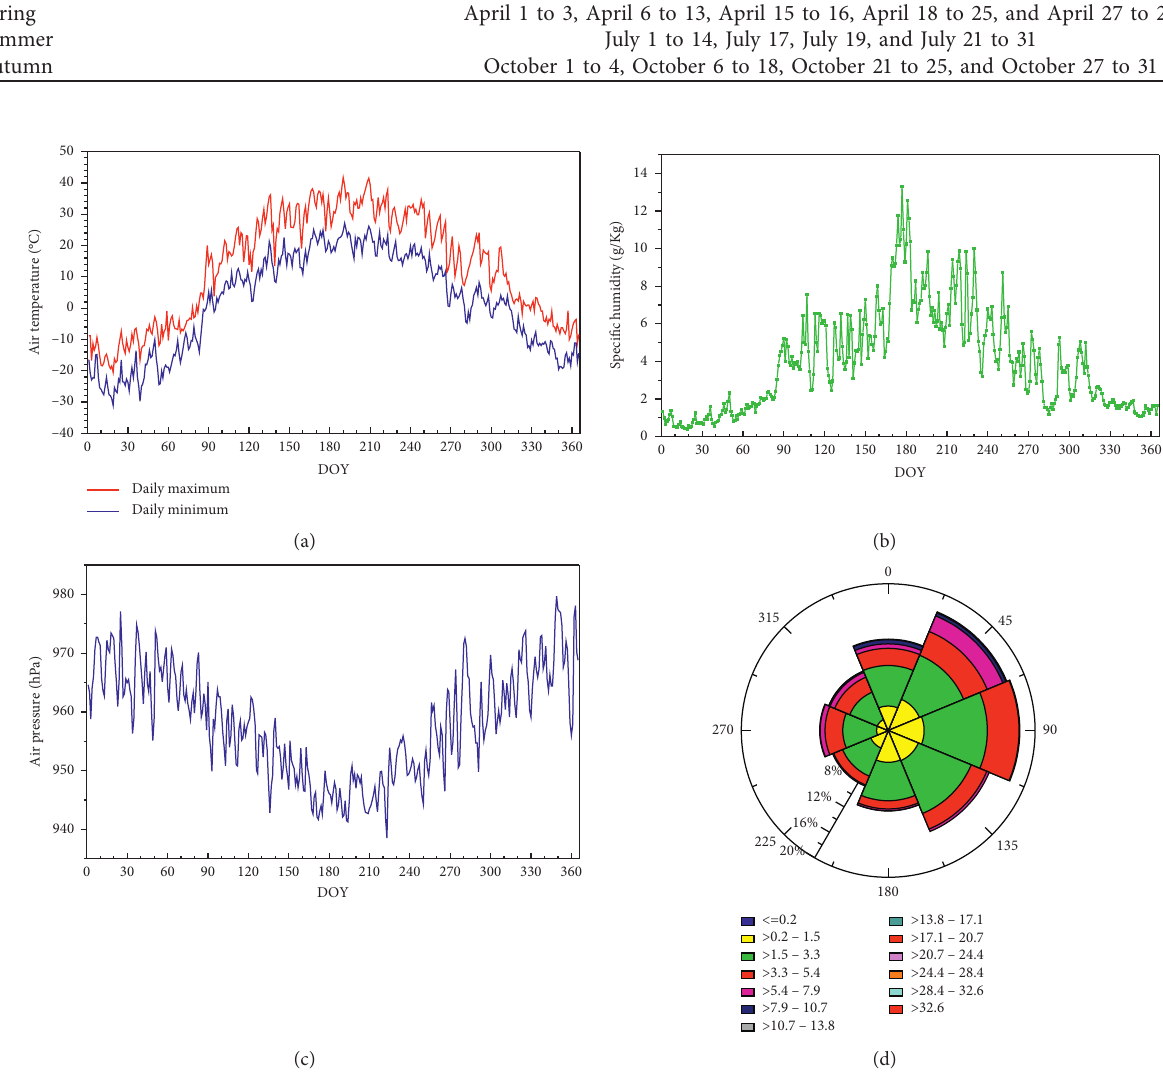
Figure 2: Meteorological conditions of the Gurbant¨ungg¨ut Desert in 2017. (a) Air temperature at 2 m. (b) Specific humidity. (c) Air pressure. (d) Wind rise at